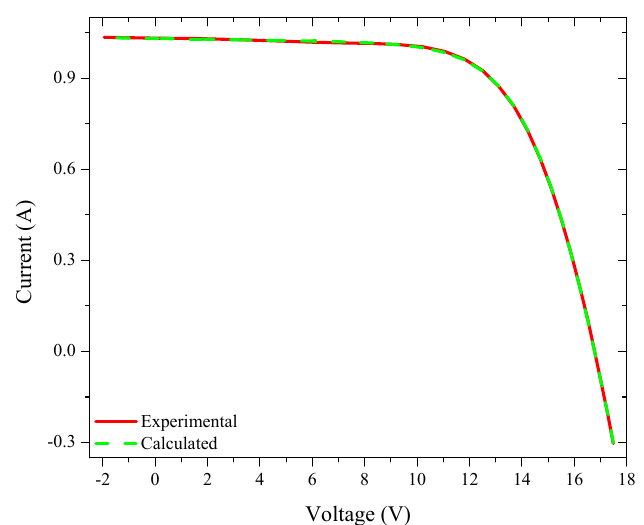
Figure 11. I–V curve of the DDM PV module for experimental and computed current values. Table 7. Obtained statistical results for SDM PV module.